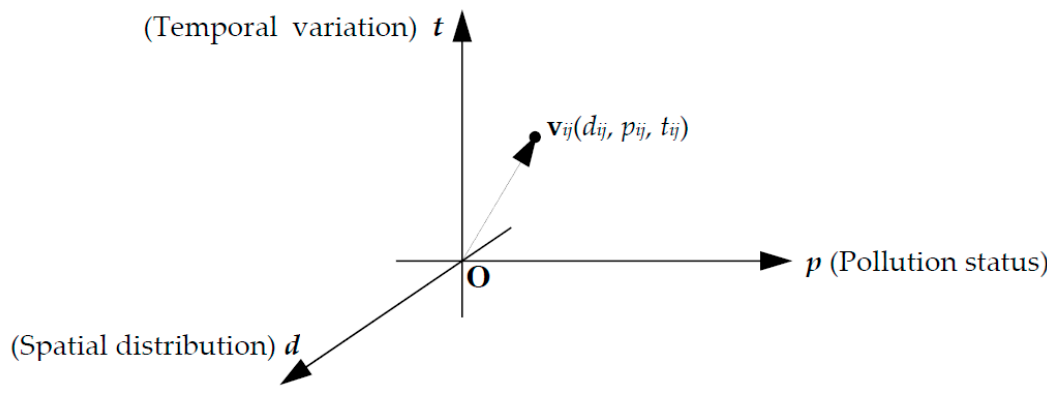
Figure 1. Sketch of the C-Space and the vector of an arbitrary variable measurement.